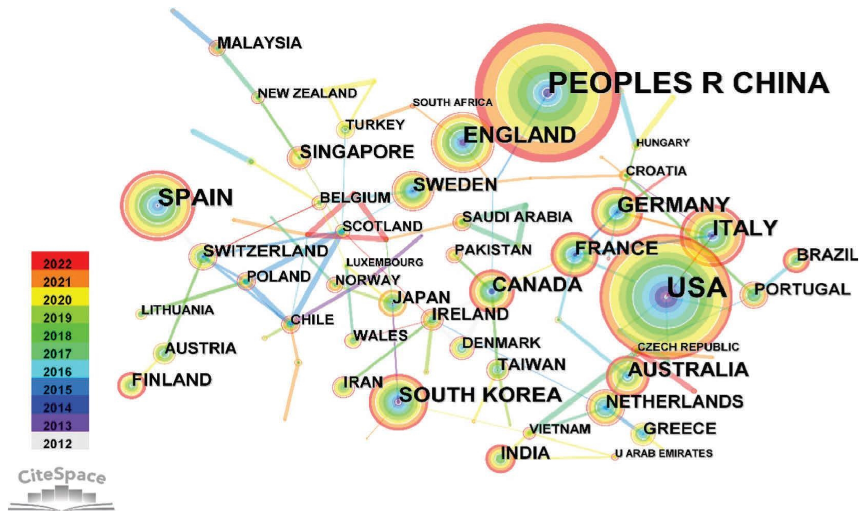
Figure 4: Spectrum of intercountry cooperation network knowledge. Table 2: Te top 10 states with high production.